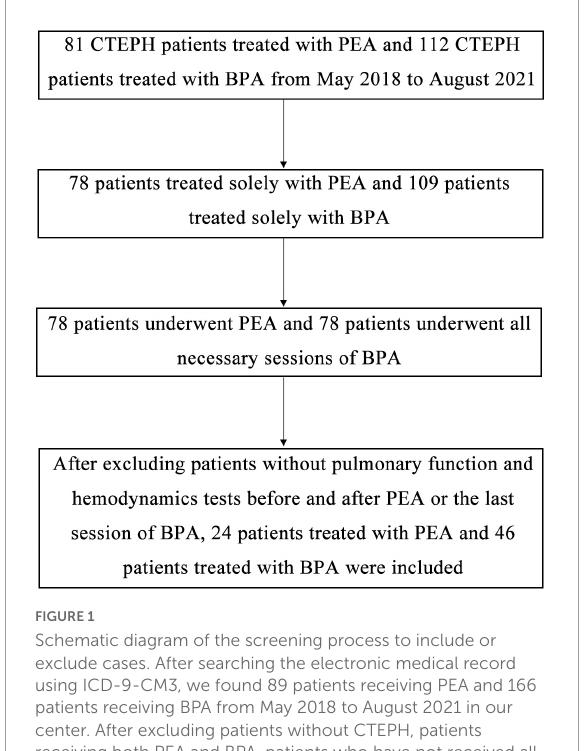
FIGURE1 Schematic diagram of the screening process to include or exclude cases. After searching the electronic medical record using ICD-9-CM3, we found 89 patients receiving PEA and 166 patients receiving BPA from May 2018 to August 2021 in our center. After excluding patients without CTEPH, patients receiving both PEA and BPA, patients who have not received all sessions of BPA, and patients without available pulmonary function test before and after intervention, we finally enrolled 24 patients treated with PEA and 46 patients treated with